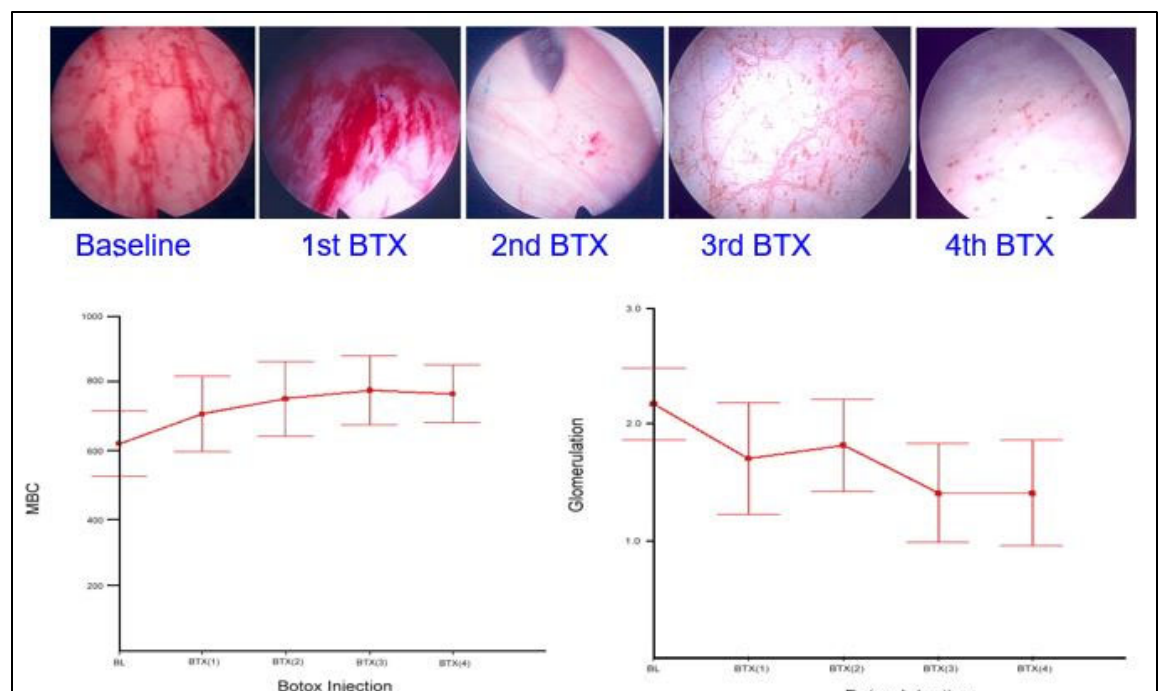
Figure 3. Changes in glomerulations and maximal bladder capacity (MBC) after repeated intravesical Botox (BTX) injections in patients with interstitial cystitis/bladder pain syndrome.